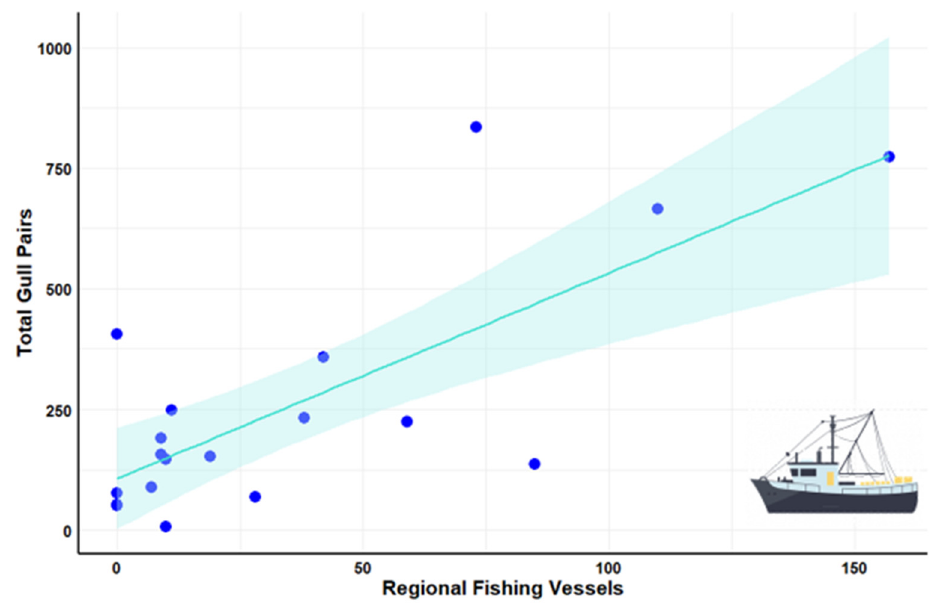
Figure 4. Plot illustrating the relationship between registered fishing vessels versus the total number of Yellow-legged Gull pairs inhabiting a region.